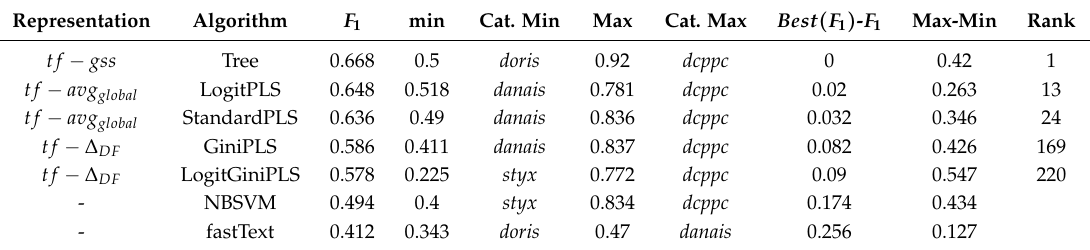
Table 8. Comparison of word representation and algorithms to detect the the judicial outcome.